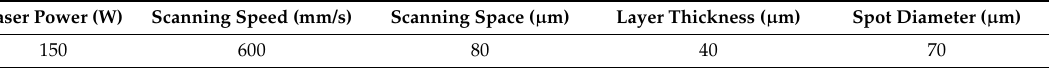
Figure 4. Schematic diagram of the laser scanning and track overlapping. Table 2. The optimized SLM fabricating parameters.